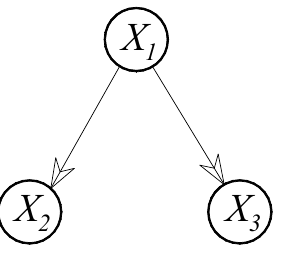
Figure 2. A Simple Bayesian Network.